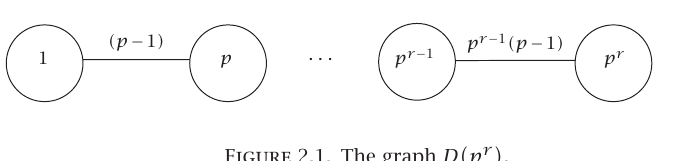
Figure 2.1 . The graph D